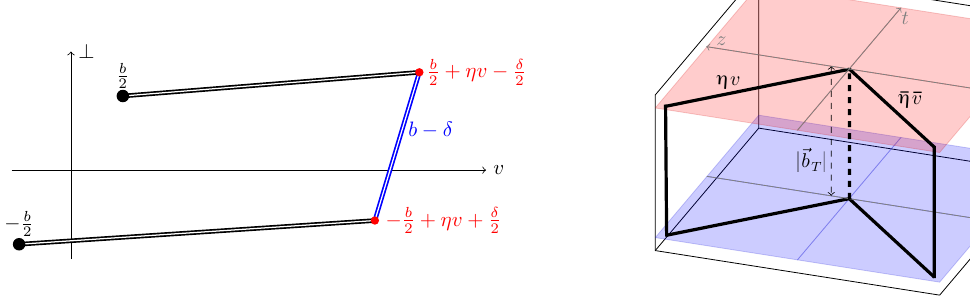
Figure 1. (a) Staple-shaped Wilson line defined in eq. (1.3). Edges may extend along the conjugate direction P , which is not shown. (b) Wilson line structure of the soft function, eq. (1.6) for η, ¯ η < 0 . Figure (a) is adapted from ref. [39] and (b) is adapted from ref.